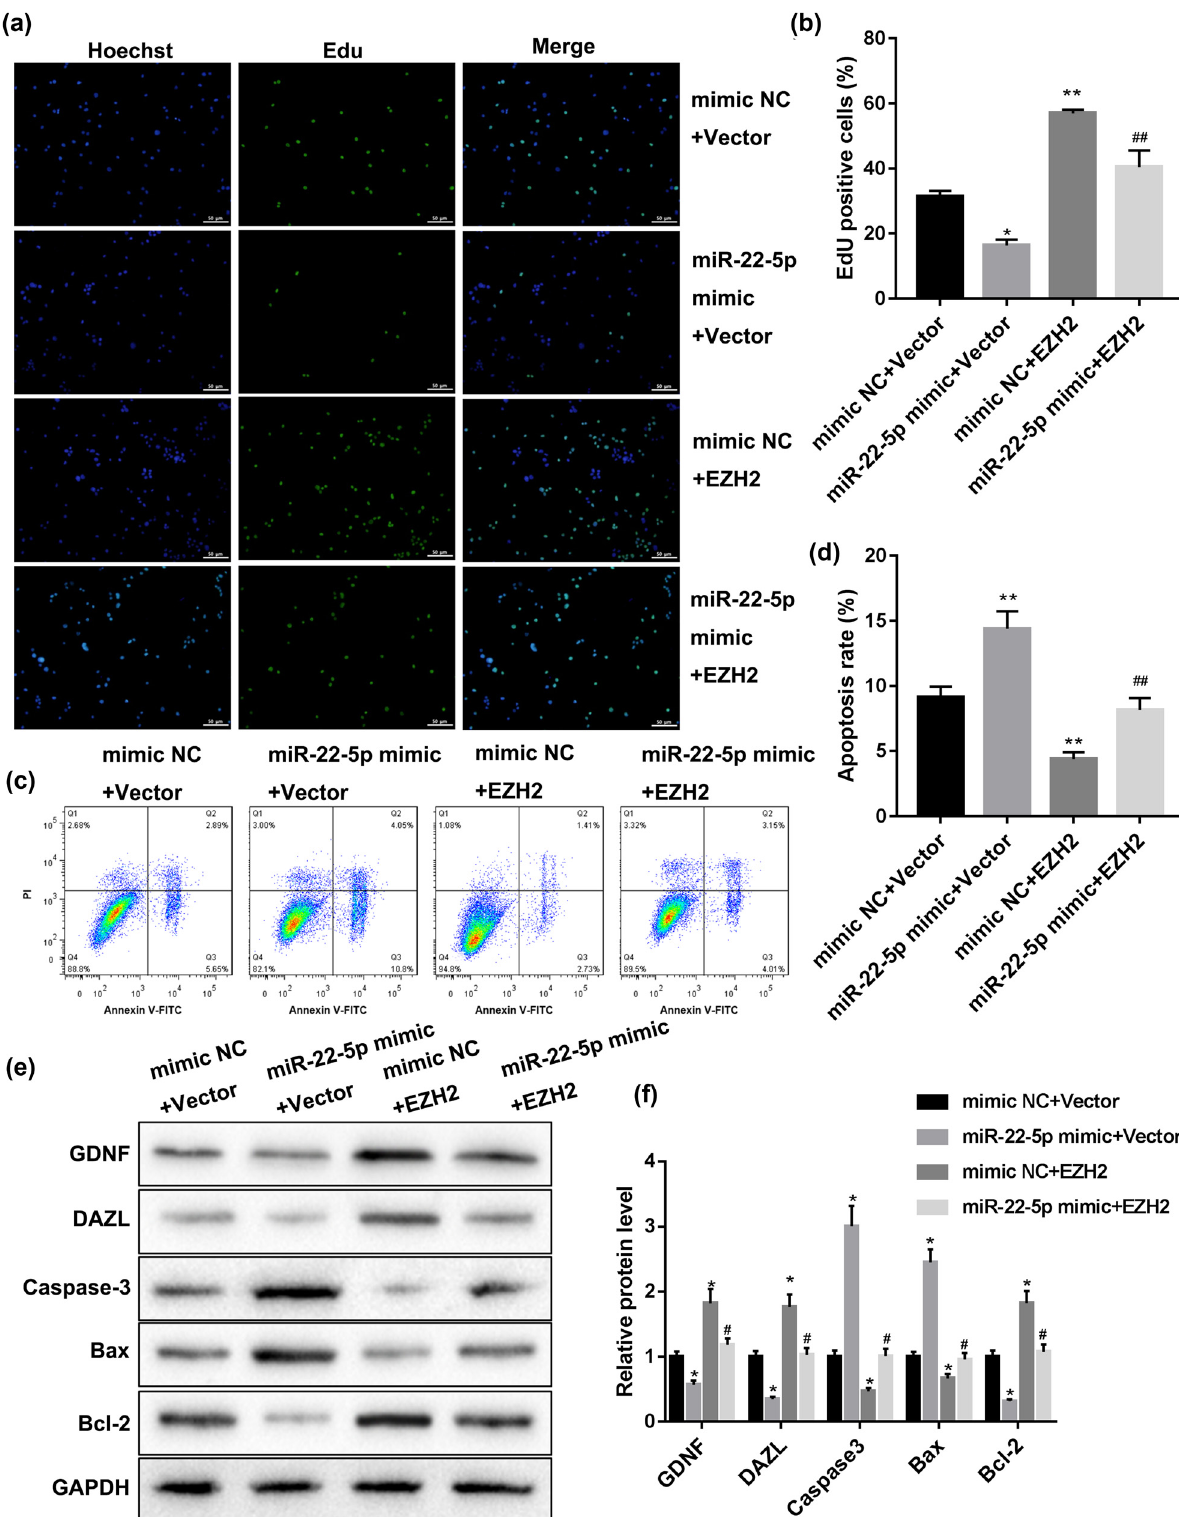
Figure 4: miR - 22 - 5p regulates SSCs ’ self - renewal by targeting EZH2. Human SSCs were co - transfected with miR - 22 - 5p mimics and the EZH2 overexpression plasmid. ( a and b ) Cell proliferation was measured by EdU staining. ( c and d ) Cell apoptosis was analyzed by Annexin V/PI staining. ( e and f ) The expression of SSC markers ( GDNF and DAZL ) and apoptosis - related proteins ( Caspase - 3, Bax and Bcl - 2 ) were detected by western blot. * p < 0.05, ** p < 0.01 vs mimic NC + vector; # p < 0.05, ## p < 0.01 vs miR - 22 - 5p mimic +